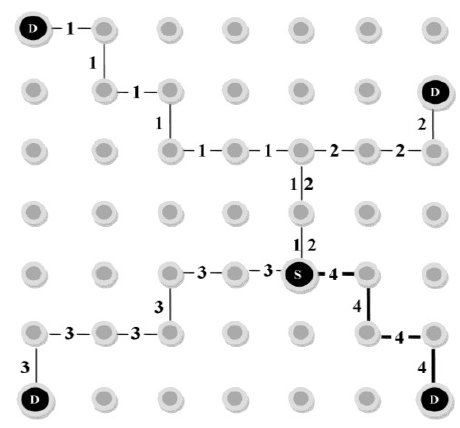
Figure 3. Path selection with minimum hop count